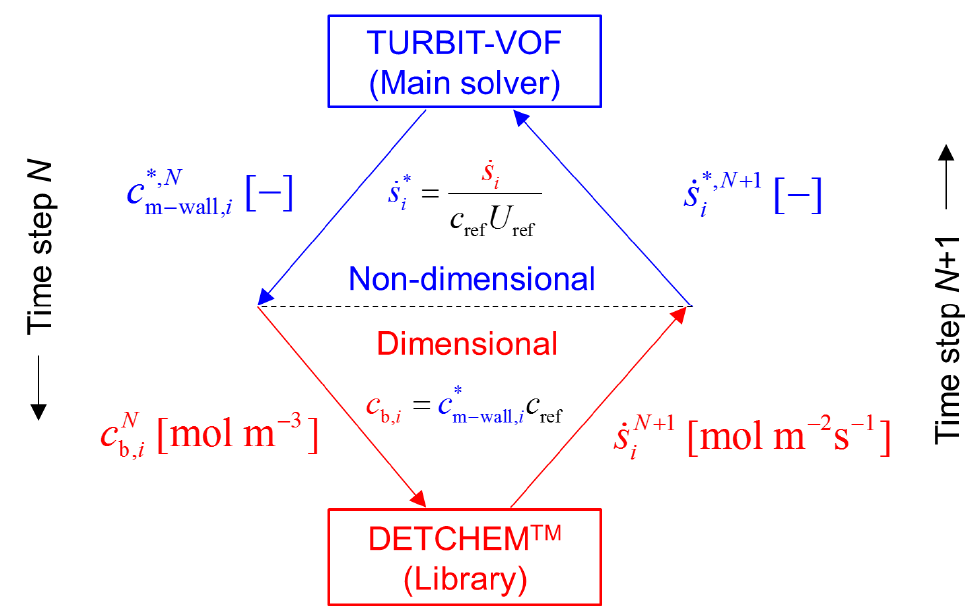
Figure 1. Sketch of coupling TURBIT-VOF and DETCHEM TM at the reactive wall for the current time step 𝑁 .